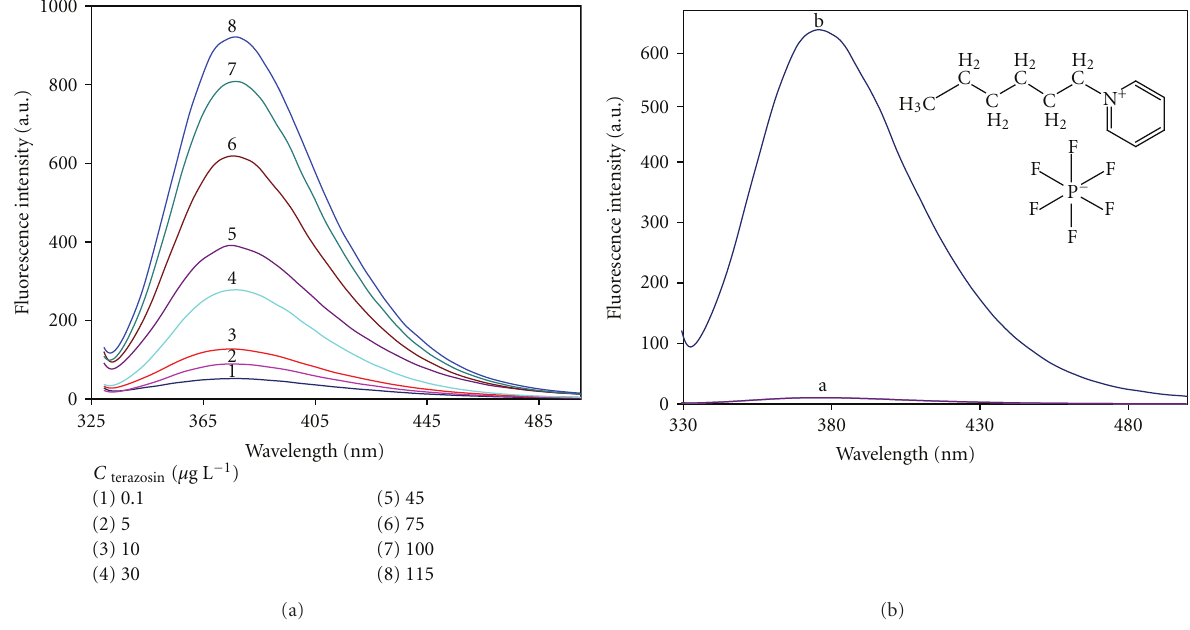
Figure 1: (a) Emission spectra obtained for 8 standard solutions of terazosin with di ff erent concentrations. (b) Emission spectrum of terazosin (75 μ gL − 1 ) treated the same as previously described in the general analytical procedure (a), and emission spectrum of reagent blank in [Hpy][PF 6 ] ionic liquid (b). Inset: chemical structure of [Hpy][PF 6 ] ionic liquid. Experimental conditions were as indicated in